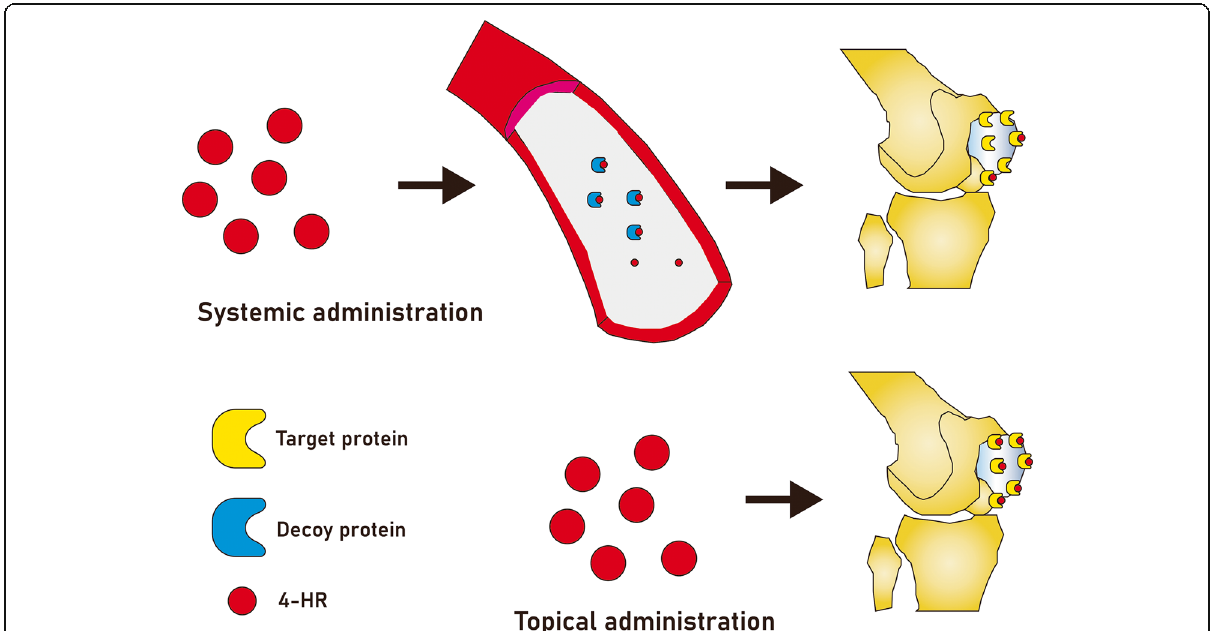
Fig. 4 Comparison between systemic administration and topical application. Systemic administration of 4HR can be done via per os, subcutaneous, or intravenous route. In any case, administered 4HR will introduce into vessel. The decoy protein for 4HR can be found in anywhere. When 4HR is bound to decoy protein, the amount of delivery to the target organ will be decreased. If wound healing is aimed, topical delivery of 4HR will be much better. If target disease is osteoporosis, 4HR should be administered systemically. In this case, smart tool for drug delivery may be required to avoid unnecessary off-target